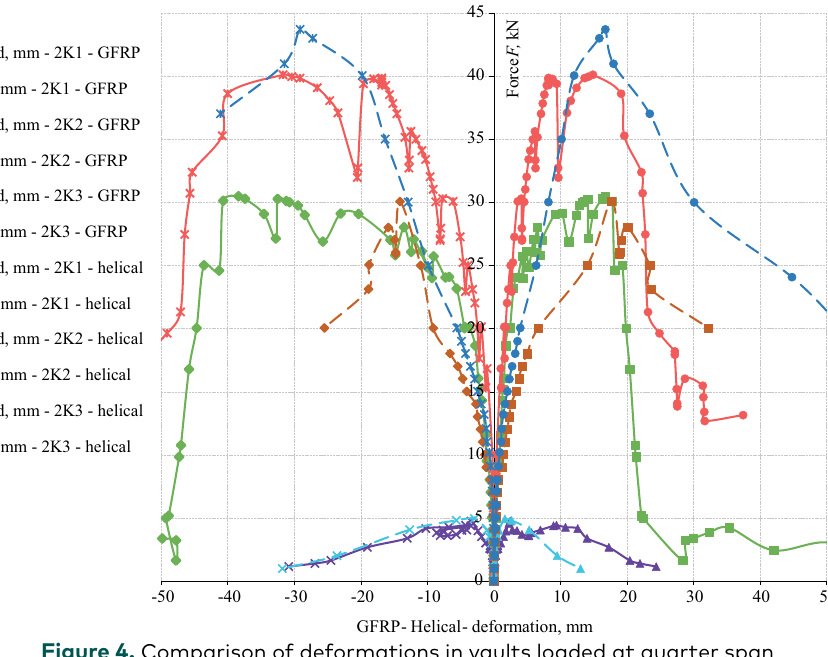
Figure 4. Comparison of deformations in vaults loaded at quarter span and strengthened with glass fibre reinforced polymer and metallic helical